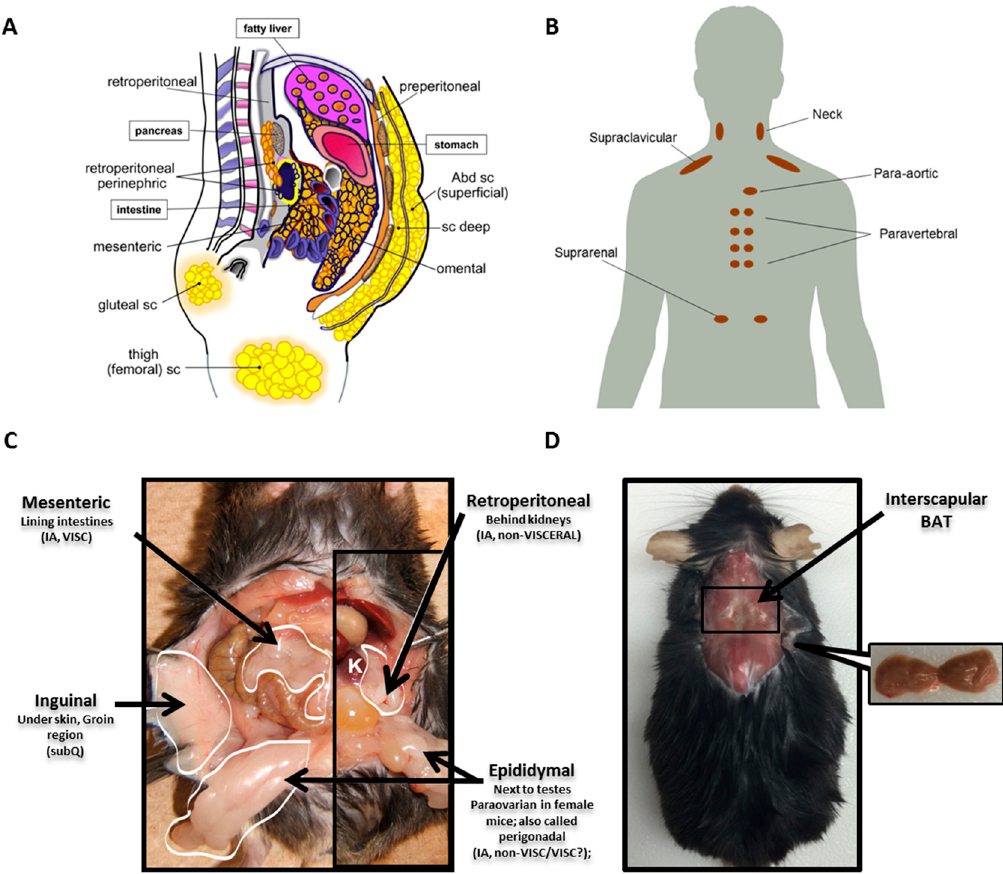
Figure 1. Distribution of white AT (WAT) and brown AT (BAT) in humans and mice. ( A ) Prominent human WAT depots are shown. Subcutaneous (subQ) depots most often studied in humans include two distinct upper body depots on the ventral side, superficial and deep, as well as gluteal and femoral fat pads. Several depots are defined as intraabdominal, including perinephric around the kidneys, retroperitoneal in the retroperitoneal space behind the kidneys and mesenteric and omental WAT lining organs of the digestive tract. ( B ) Several human BAT depots are depicted. BAT in adult humans is present in several different locations, including the neck, heart, spinal cord and kidneys. However, the majority is contained within the supraclavicular depot. ( C ) Four commonly-studied WAT depots in a male mouse are shown. Inguinal fat is a subQ depot that lies just beneath the skin and is similar to the gluteofemoral subQ in humans. Intraabdominal depots include mesenteric fat associated with the intestine, retroperitoneal behind the kidneys (K) and epididymal WAT next to the testes (paraovarian surrounds the ovaries of female mice; collectively, epididymal and paraovarian are also called perigonadal). According to the stricter rules of nomenclature, only mesenteric fat is a true visceral depot in mice, as it is the only one that drains into the portal vein. ( D ) The location of the interscapular BAT depot in mice, the only dissectible BAT fat pad, is shown. Abd sc: Abdominal subcutaneous; IA: Intraabdominal; VISC: Visceral. Figure 1A is adapted with permission from [1].